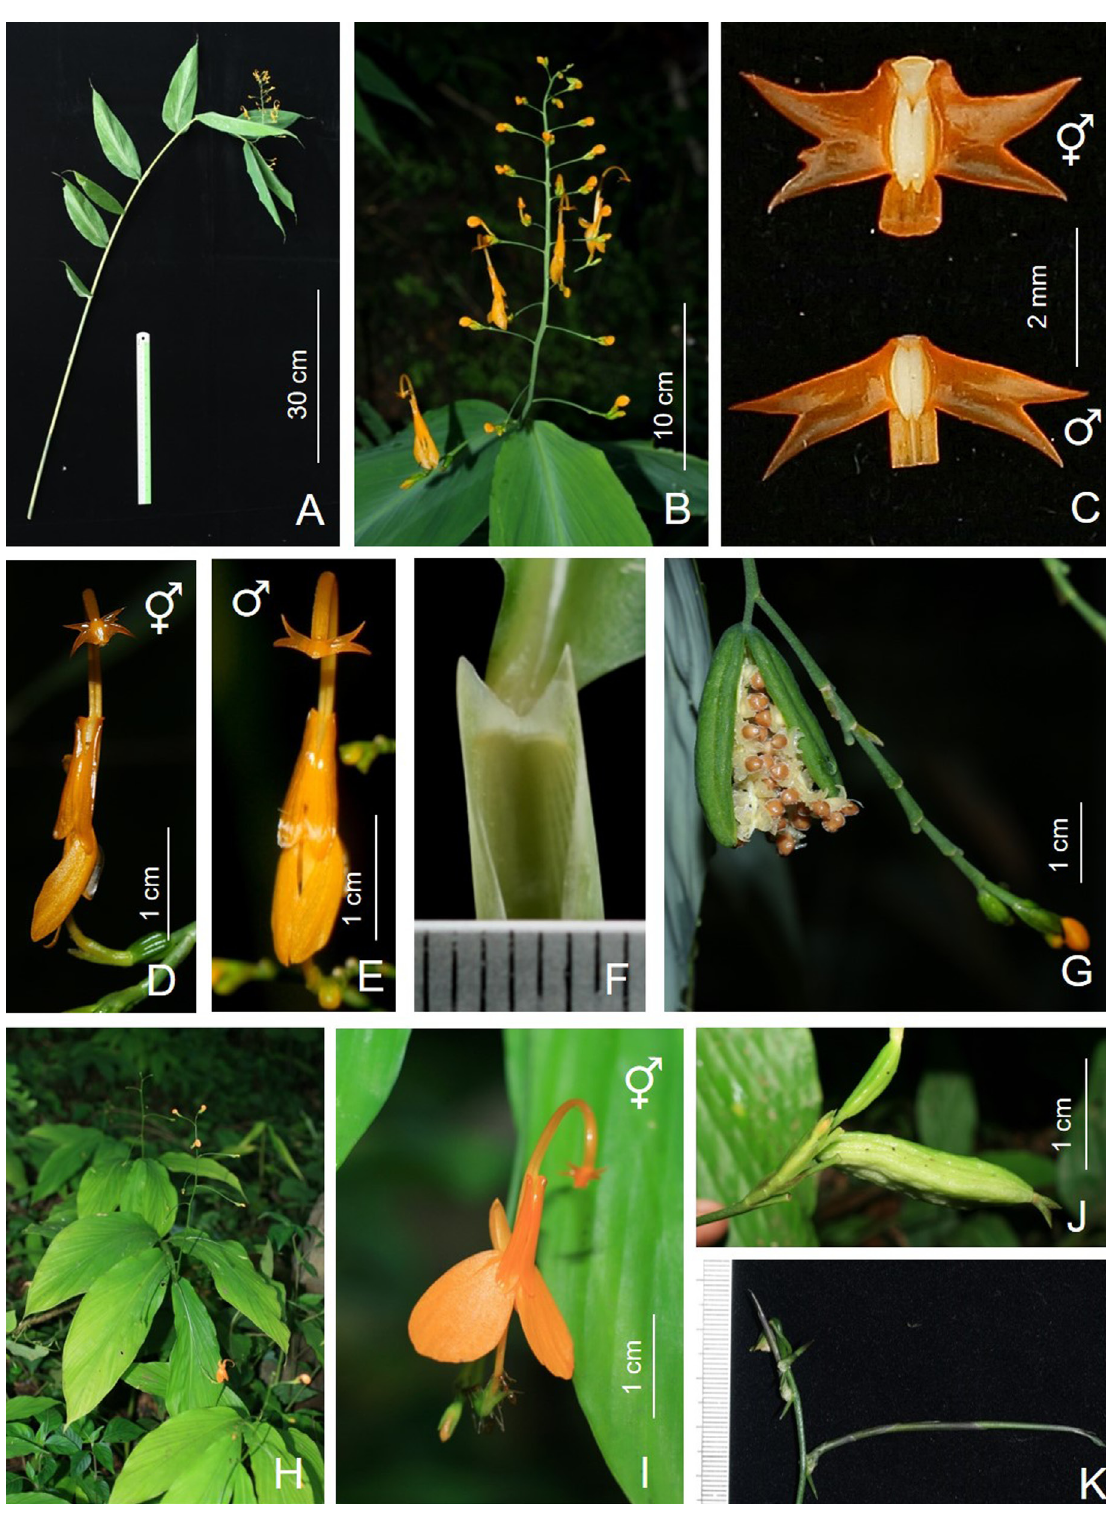
Fig. 7. A – G . G. expansa Wall. ex Horan. A . Habit. B . Inflorescence. C . c (above) and ♂ (below) appendages. D . c flower. E . ♂ flower. F . Ligule. G . Mature fruit with seed (M.F. Newman 2561 leg.). H – K . G. flagellaris K.Larsen. H . Habit. I . c flower. J . Fruit. K . Bulbils (M.F. Newman 2581 leg.). Photographs: S.